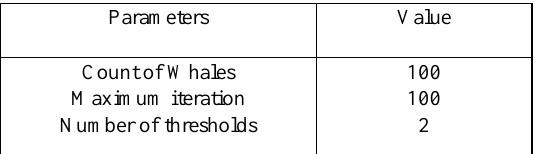
Table 4. Used Whale Optimization parameters